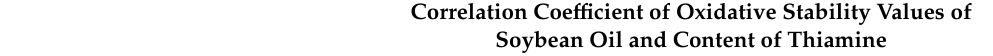
Table 2. Correlation coe ffi cients between oxidative stability values of soybean oil and content of thiamine pyrophosphate in presence of ethanol tea extracts.